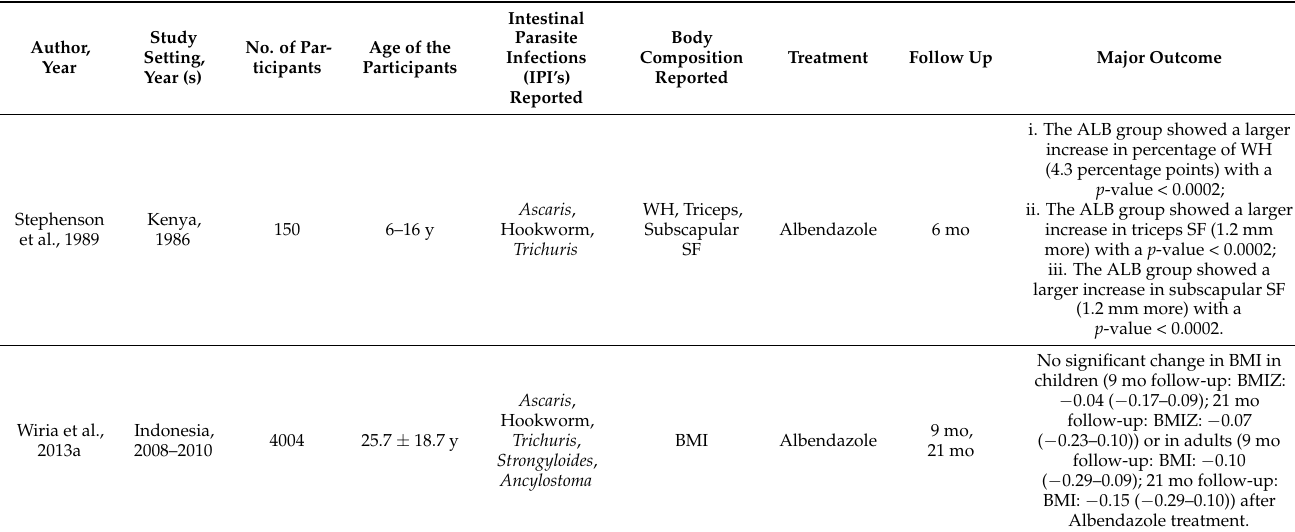
Table 3. Characteristics of the experimental studies included (RCT’s).